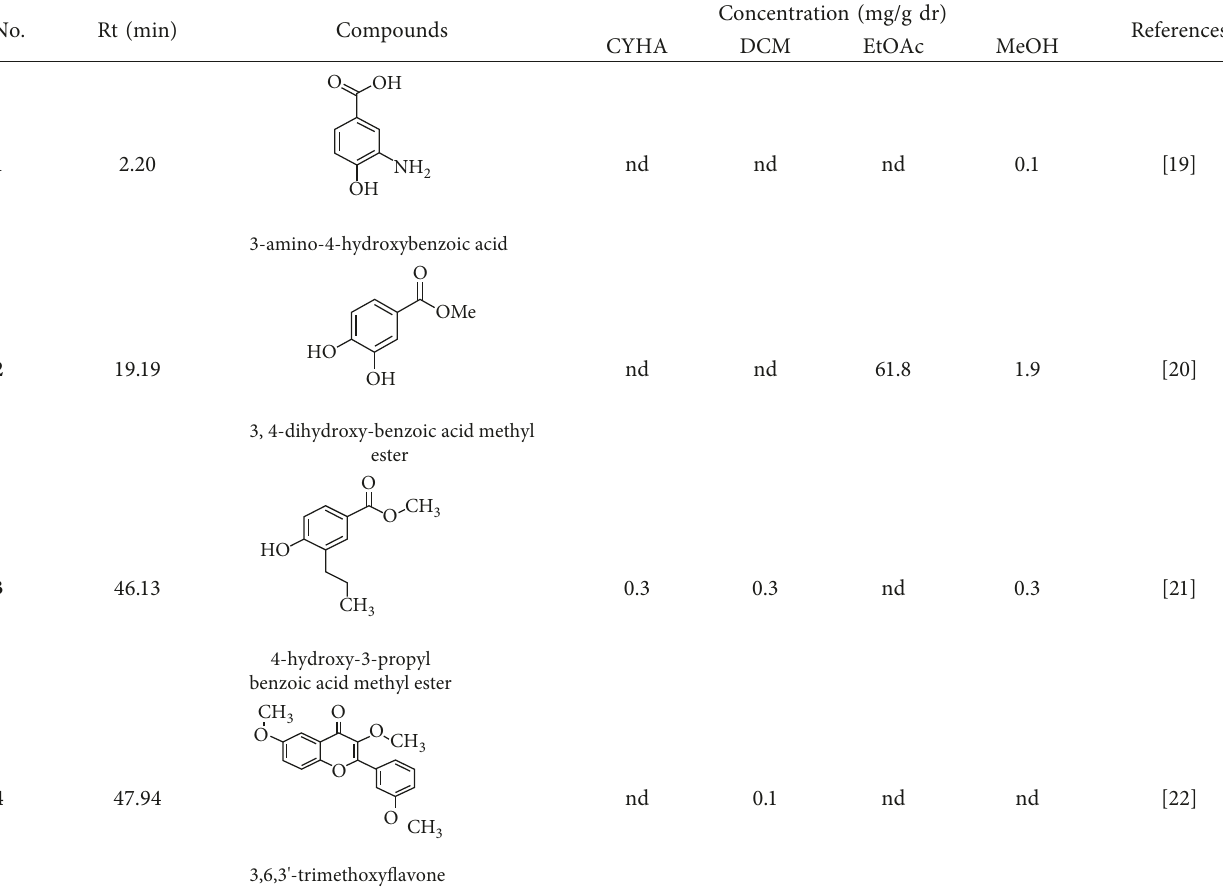
Table 4: Phenolic compounds identified in the different extracts of Manilkara mabokeensis Aubr´ev bark by HPLC- DAD. No. Rt